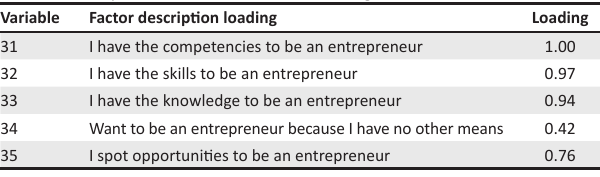
ambiguous wording of the sentence.